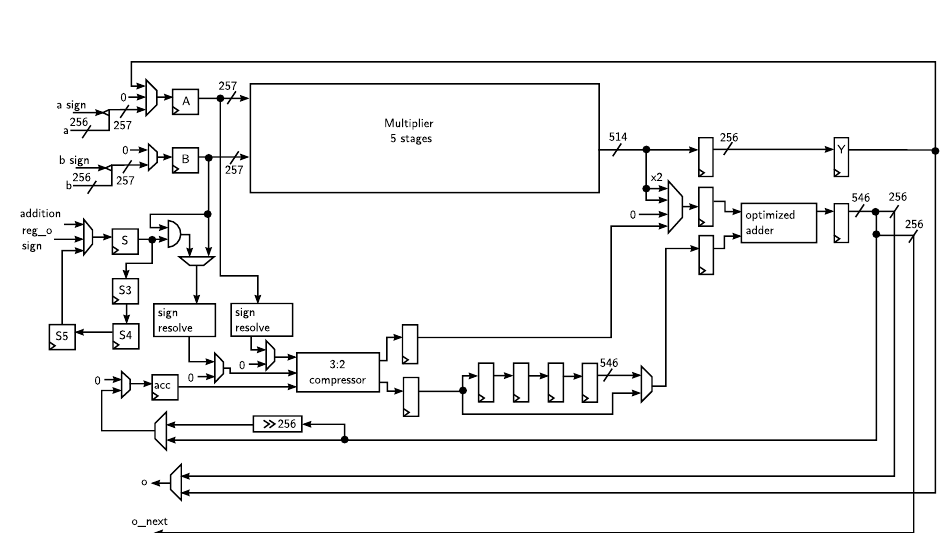
Figure 8: The 8-stage pipeline multiplier accumulator Carmela256 .